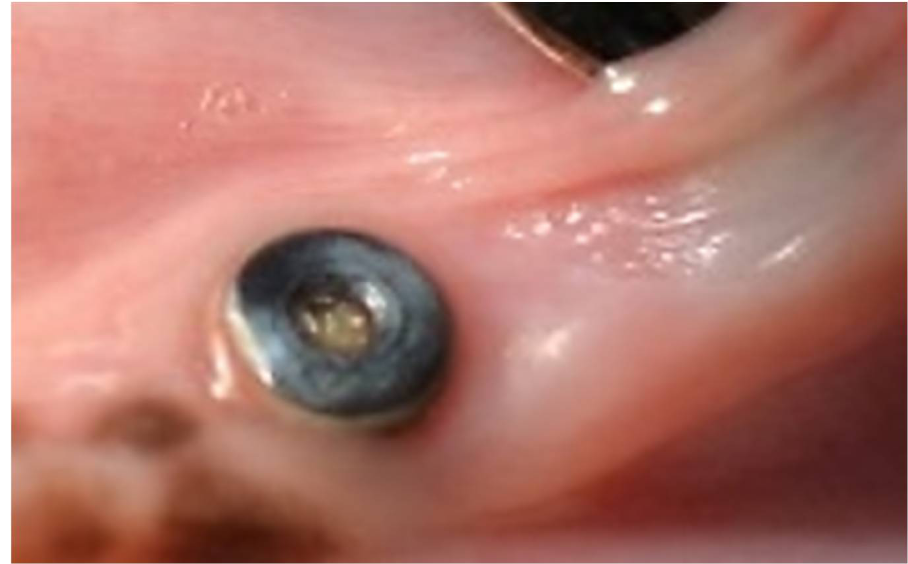
Figure 6. The cover screw is completely